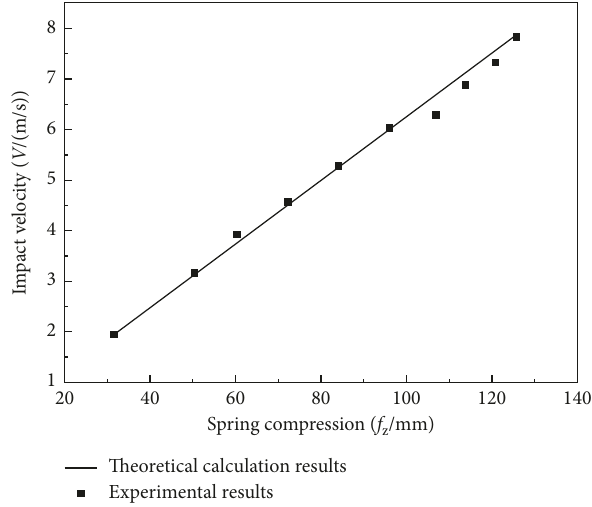
Figure 14: Energy storage values of two types of springs.